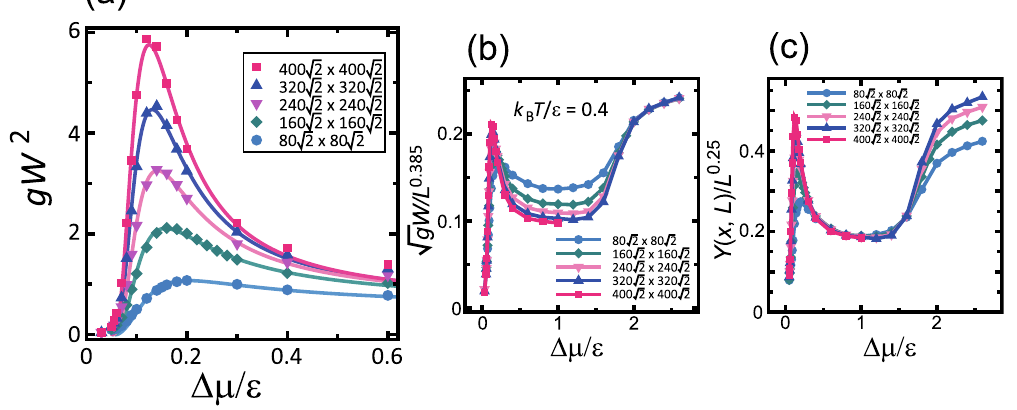
1 . ( a ) 0.9 . k B T /ǫ 0.4 . a = = − =